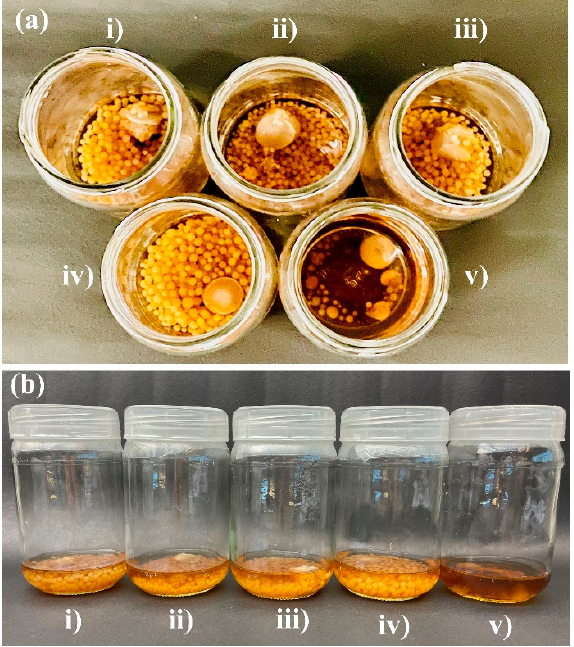
Figure 5. The growth enhancement of P. indica when treated with silver nanoparticles in 4% jaggery broth media prepared at pH 6.7: ( a ) Top view, ( b ) front view. Note: (i) Control, (ii) 100 ppm, (iii) 200 ppm, (iv) 300 ppm, and (v) 400 ppm. Growth retardation was observed in higher